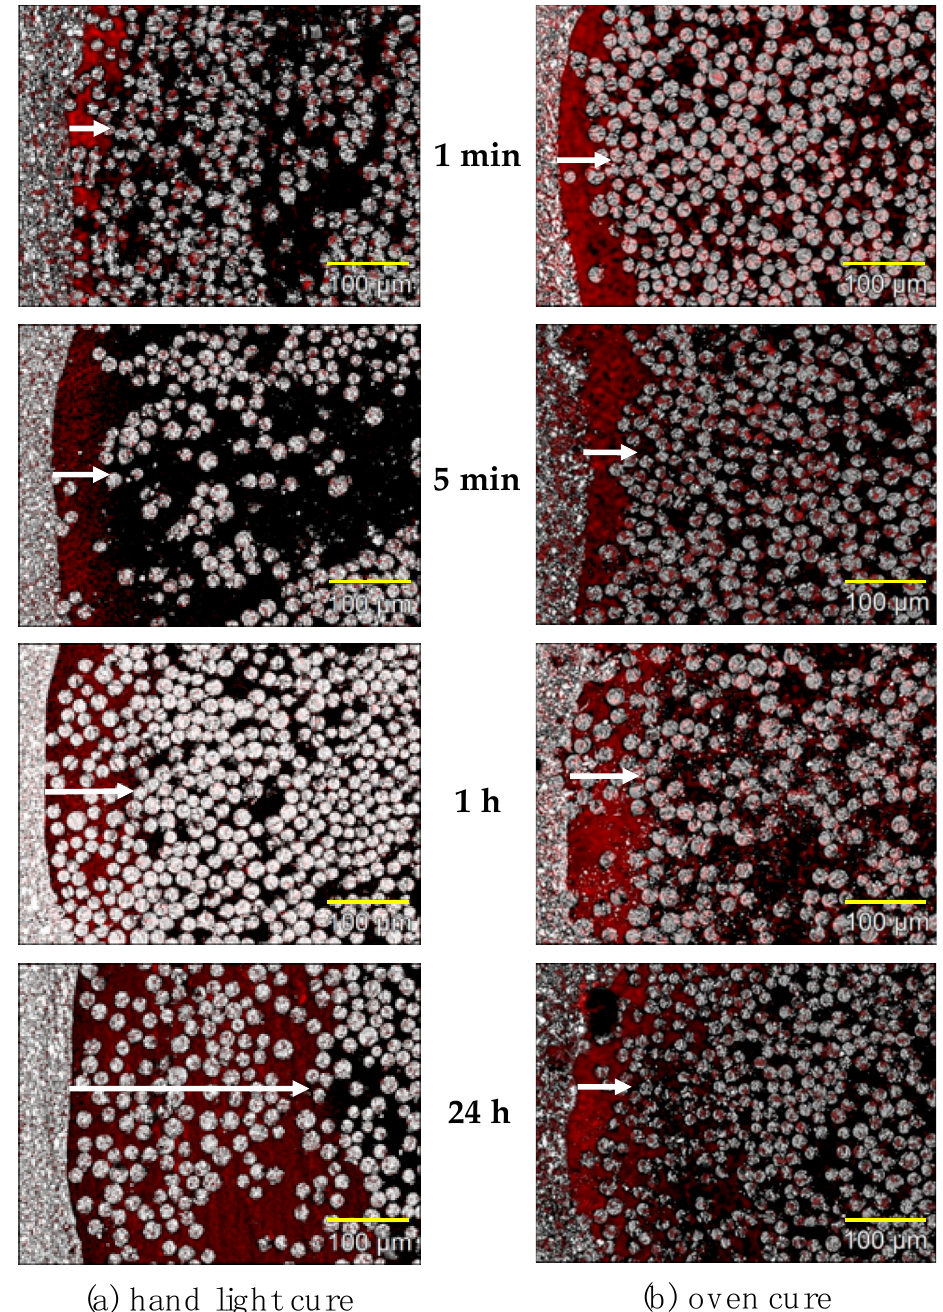
Figure 5. SEM photographs of the penetration conditions of priming agents into everStick POST: ( a ) hand light cured after 1 min, 5 min, 1 h, and 24 h, ( b ) oven cured after 1 min, 5 min, 1 h, and 24 h of immersion time.